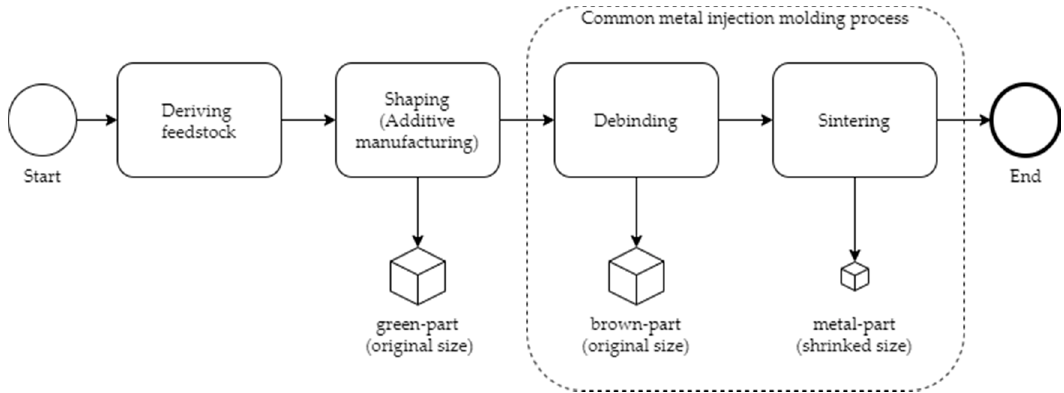
Figure 1. Schematic process of metal extrusion based Additive Manufacturing EAM.